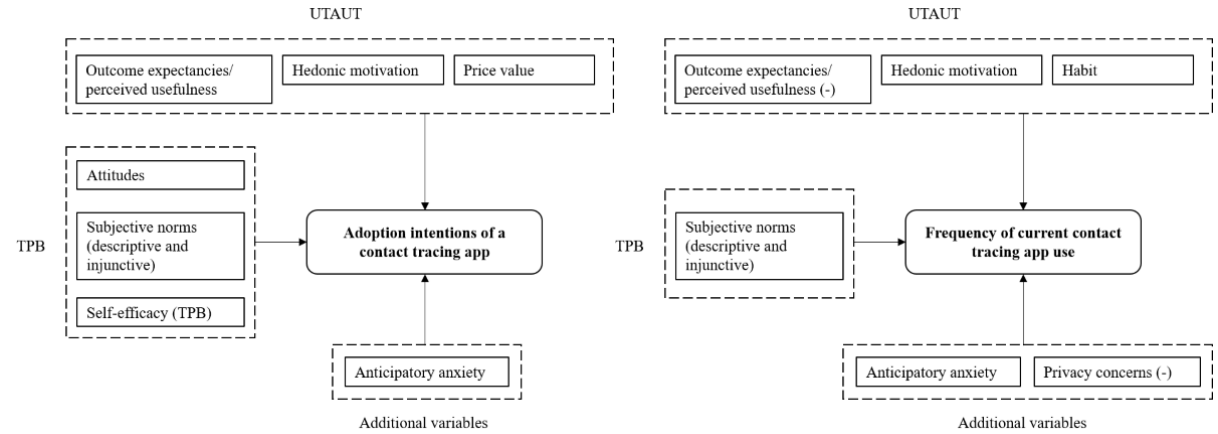
Figure 4. Significant predictor variables of adoption intentions and (frequency) of current COVID-19 contact tracing app use in a German community sample. Predictors are categorized according to the theory of planned behavior (TPB), the unified theory of technology acceptance and use (UTAUT), and additional variables from other health behavior models (ie, anticipatory anxiety) or previously extended UTAUT models (ie, data privacy